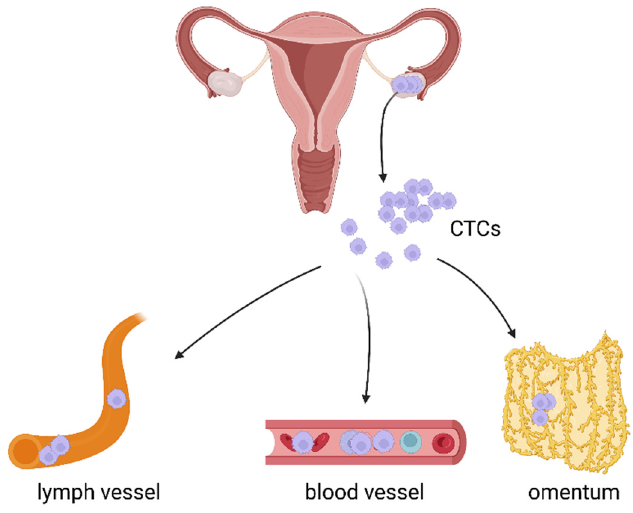
Figure 1. Three main routes of cancer cell dissemination: transcoelomic, hematogenous, and lymphatic. Created with https://biorender.com/, (accessed on 31 October 2022). The most common and best known route of OC spread is the transcoelomic route. It is peritoneal organs [4,5]. In this type of cancer, the dissemination of single cells, multicellular [6].